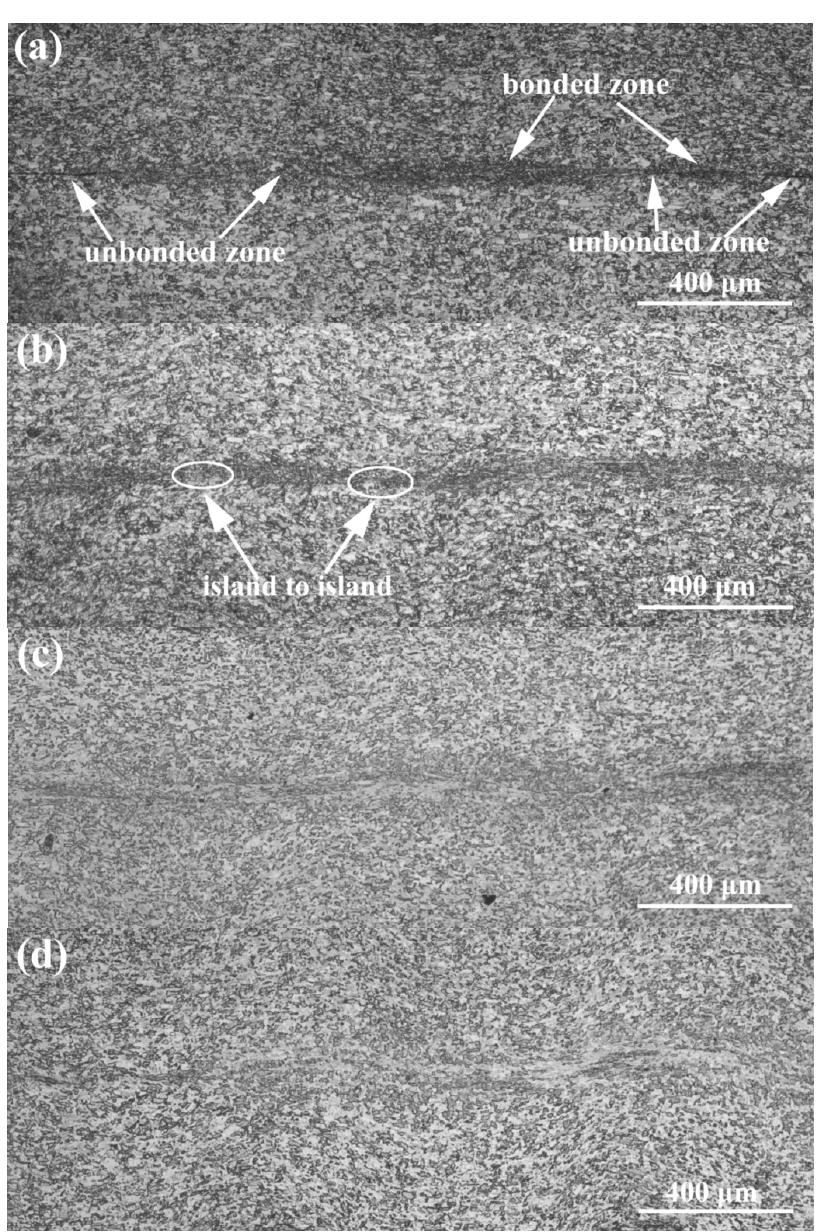
Figure 3. Cont. Figure 3.